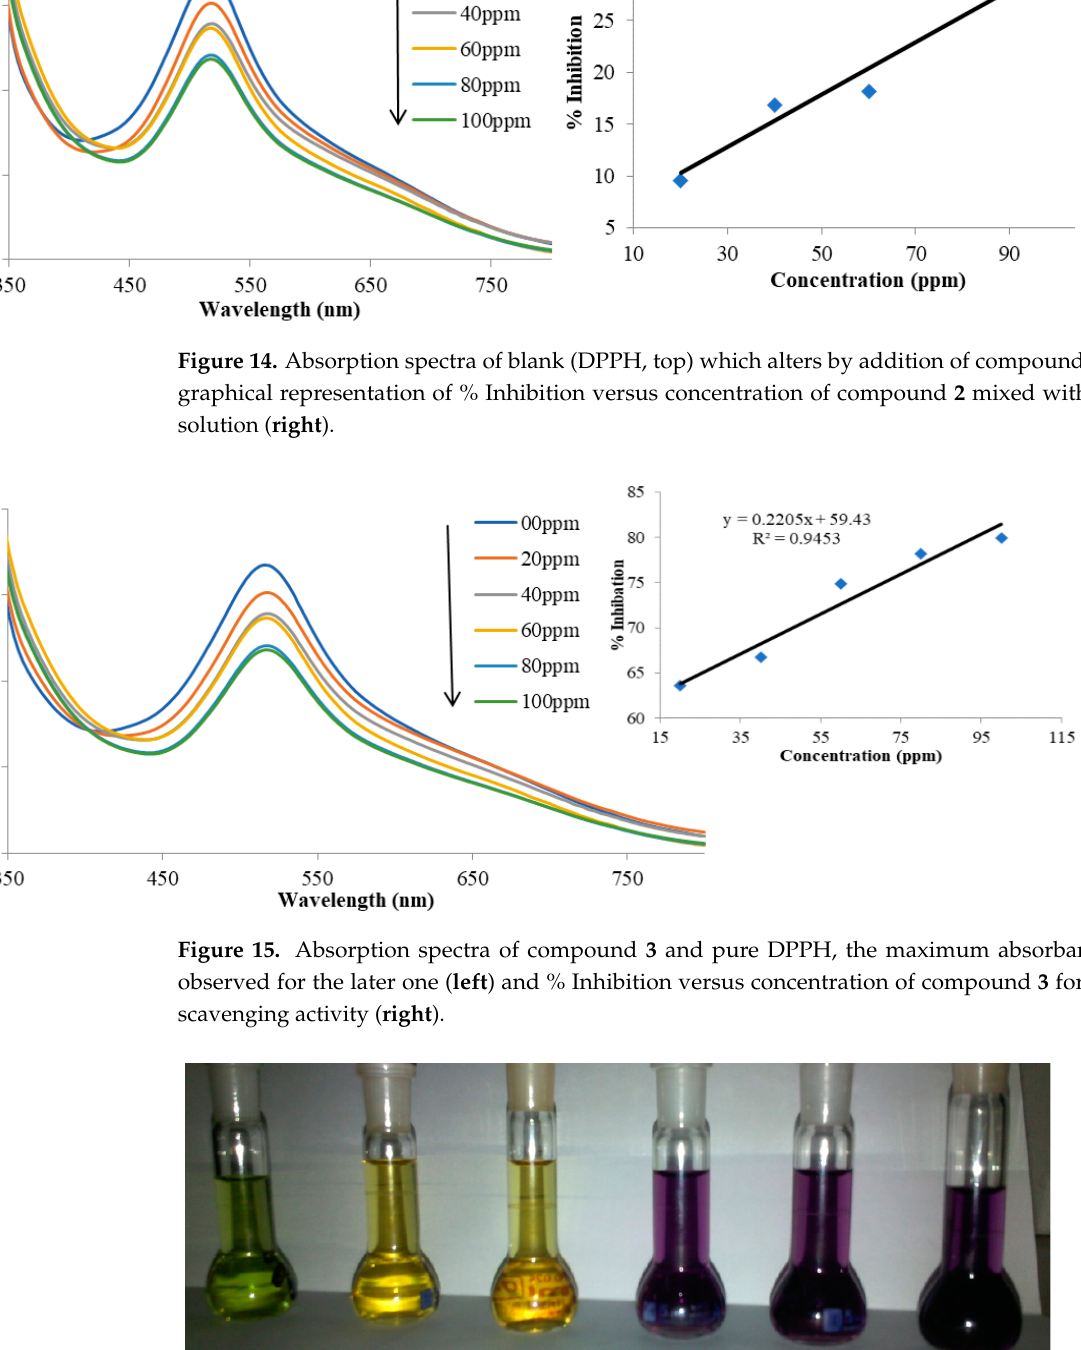
Figure 16. Naked eye detection of anti-DPPH radical scavenging activity shown by compound 2 . The solution having purple color on right hand side is blank (without antioxidant agent) and that on left hand side contains 100 ppm of the antioxidant agent.